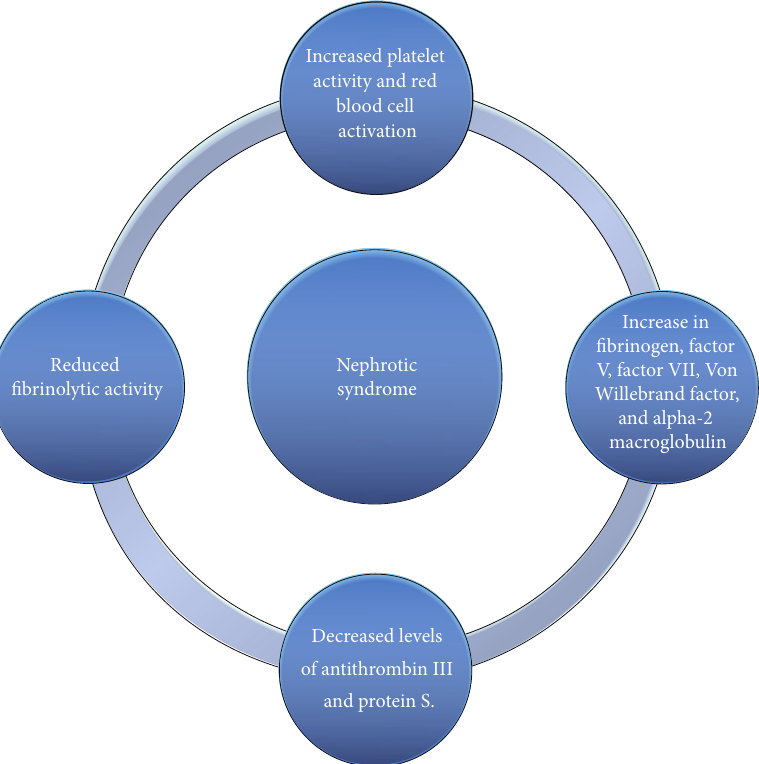
Figure 1: A simplified sketch on the pathogenesis of NS-related thrombotic risk.